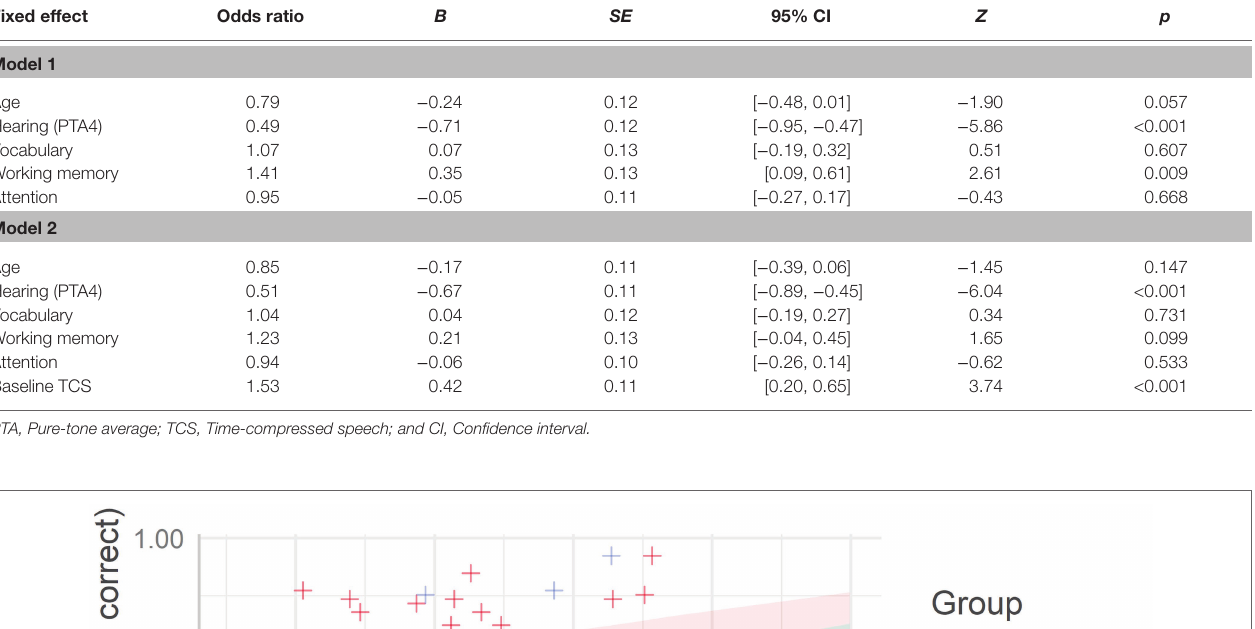
TABLE 7 | Results of generalizedlinear mixed-effects model for speech in noise recognition as a function of the background variables (Model 1) and as a function of age, hearing, cognition, and baseline recognition of time-compressed speech as fixed effects (Model 2). Fixed effect